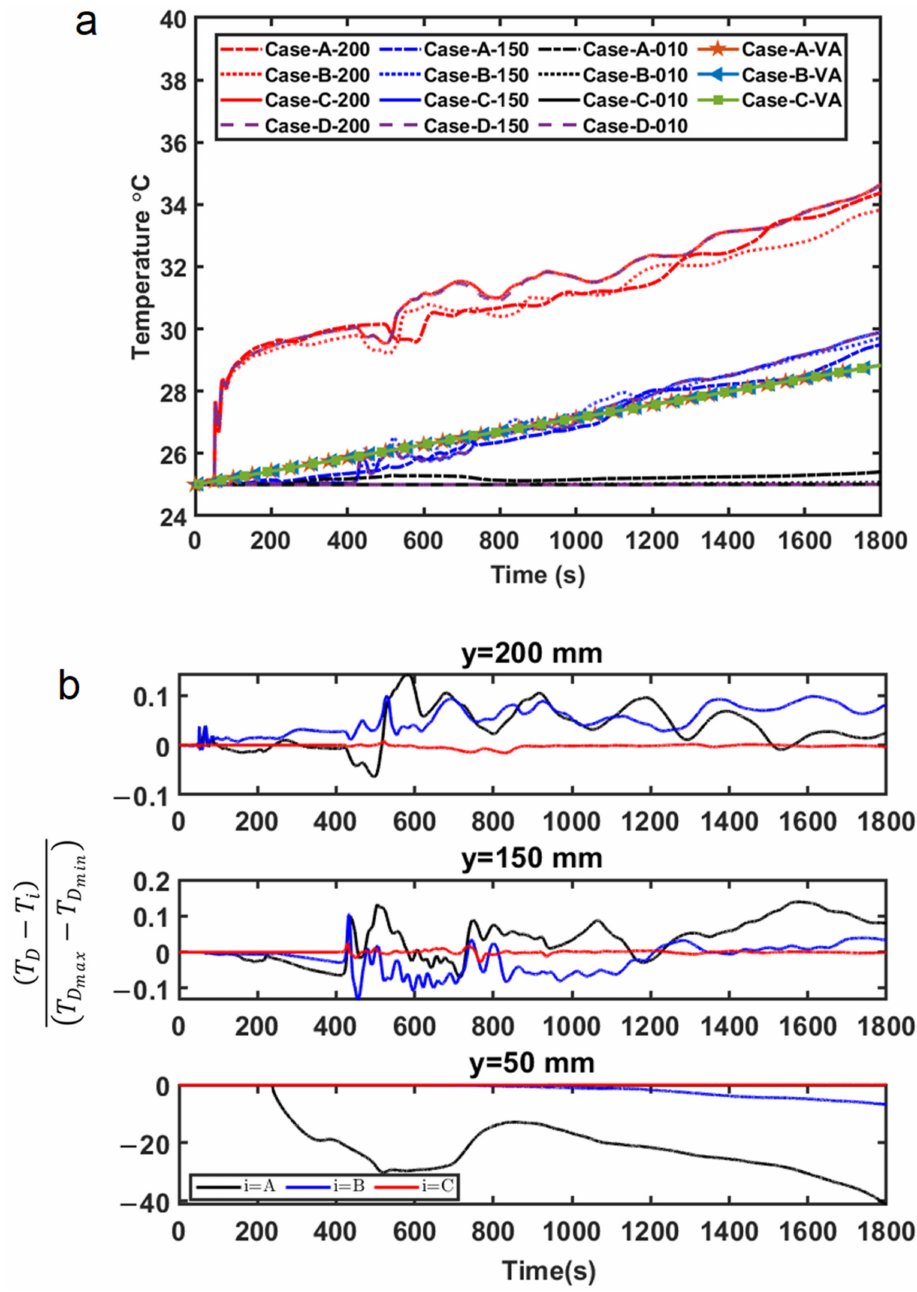
Figure 3. ( a ) Space (grid) and time-step sensitivity study showing the temporal variation in tem- perature at three points at different heights, viz. 10 mm, 150 mm, and 200 mm along with the volume-averaged (VA) bulk temperature of the pool. ( b ) Non-dimensional temperature fluctuation in various grids relative to the finest grid (case D) at three points for different heights viz. 10 mm, 150 mm, and 200